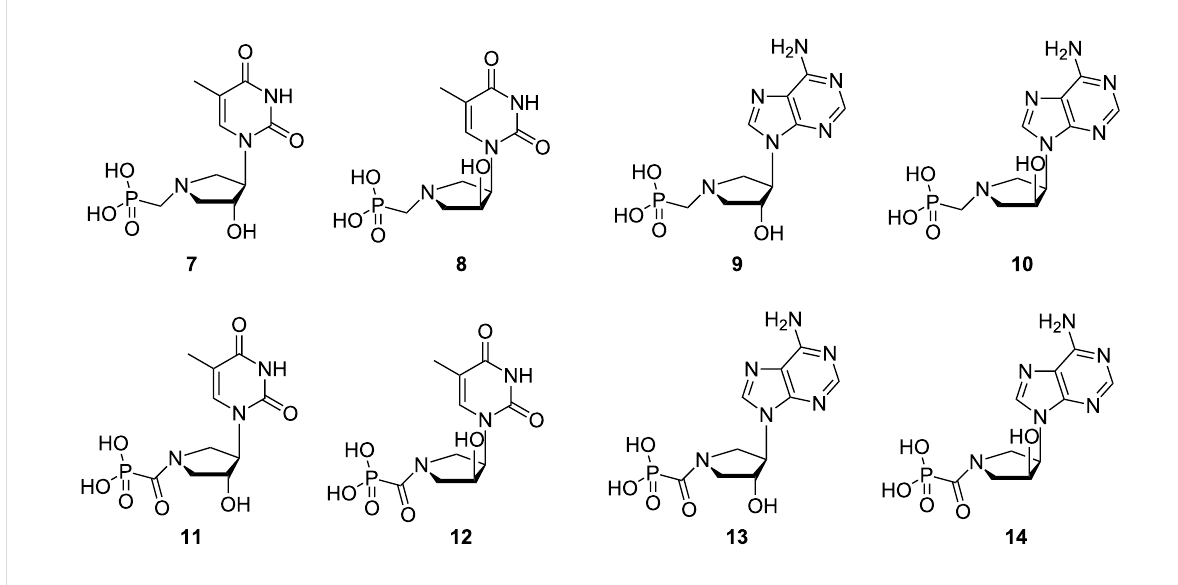
Figure 2: The pyrrolidine nucleotide analogs investigated in this study.